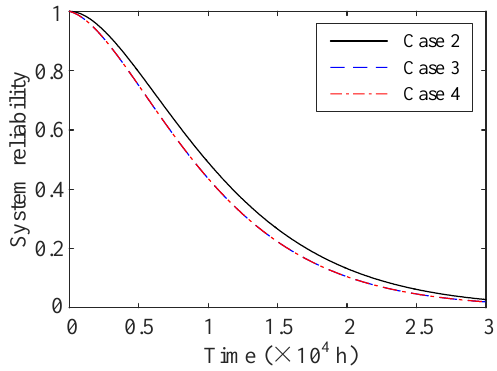
Figure 12. System reliability with different swapping